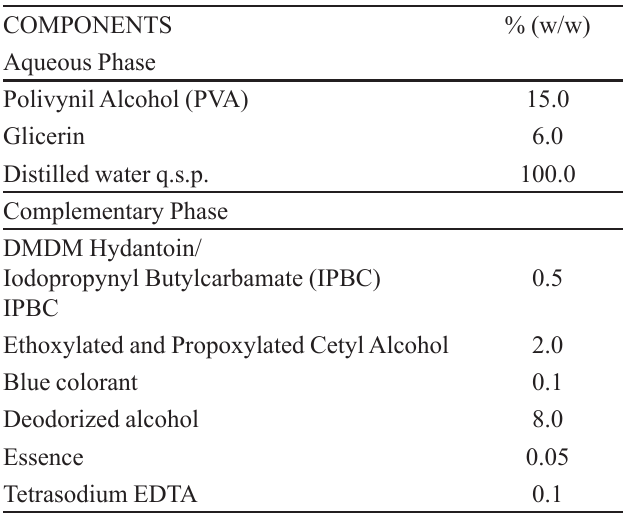
TABLE I - Composition of cosmetic base F35 selected in the Screening Study